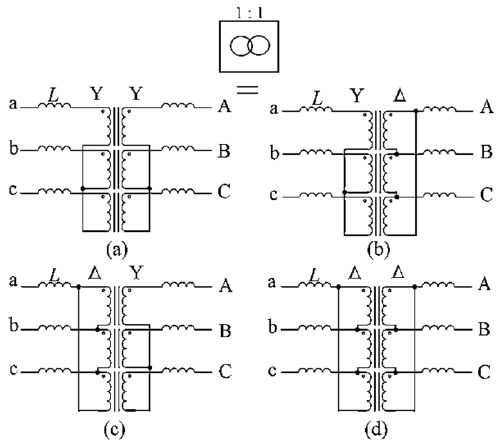
Figure 1. A bidirectional isolated DC-DC converter topology.